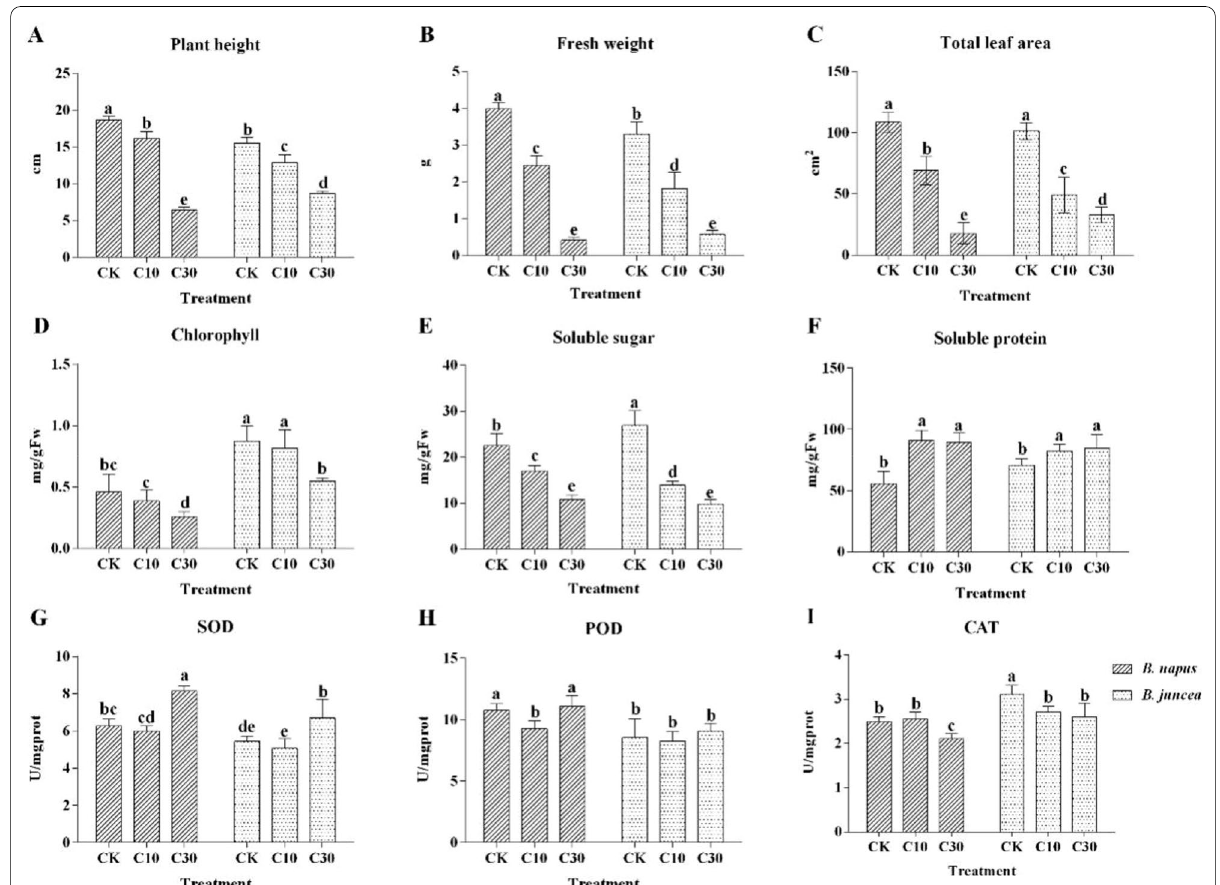
Fig. 1 Effect of Cd on plant physiological properties. Error bars show standard deviation (n significantly different at P < 0.05 based on one-way ANOVA. CK treatment with 0 mg/kg Cd, C10 treatment with 10 mg/kg Cd, C30 treatment with 30 mg/kg Cd, the same